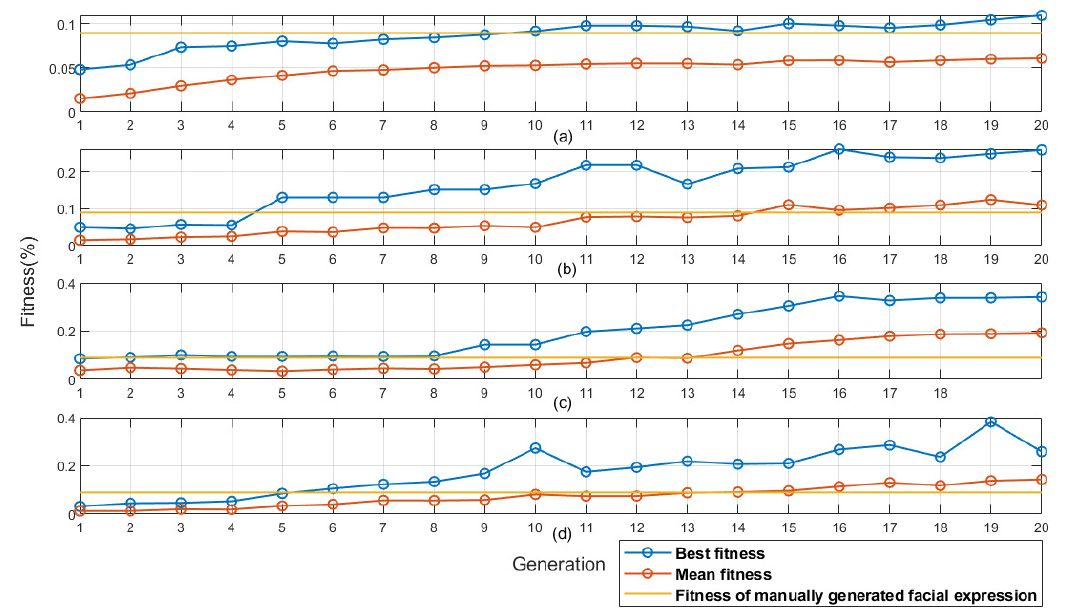
Figure 13. Comparison of Fitness of Facial Expression by GA